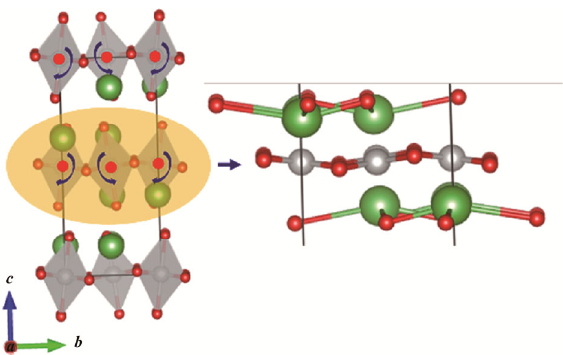
Fig. 3 Schematic diagram of systematic canting of MO (cid:2874) octahedra. The buckling of MO (cid:2870) and RE (cid:2870) O (cid:2870) interlayers is highlighted in magnified part of